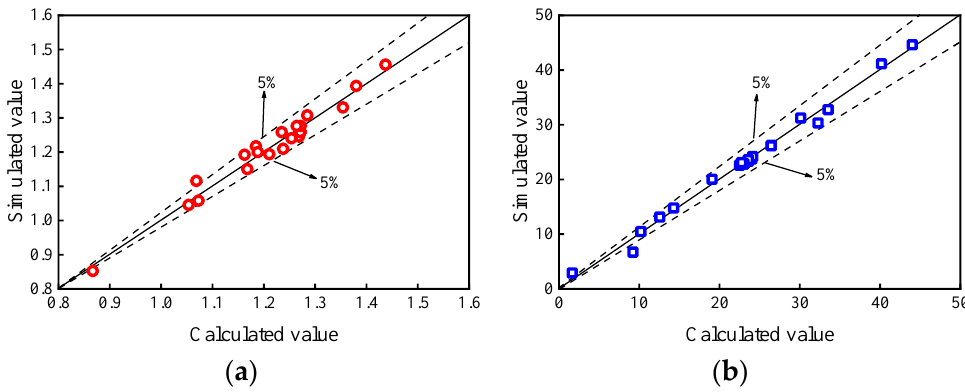
Figure 9. Comparison of calculated and simulated values. ( a ) DIF. ( b ) u stab /mm.